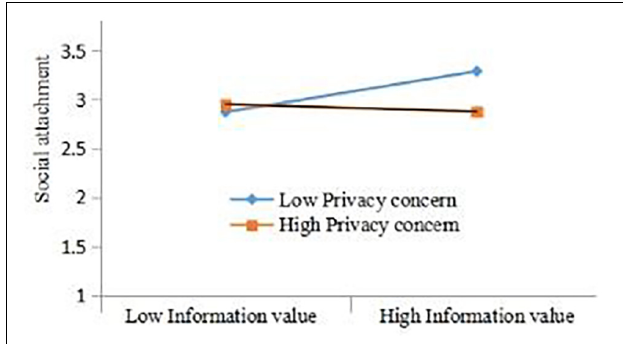
FIGURE 2 | Privacy concern moderating the relationship between social attachment and information